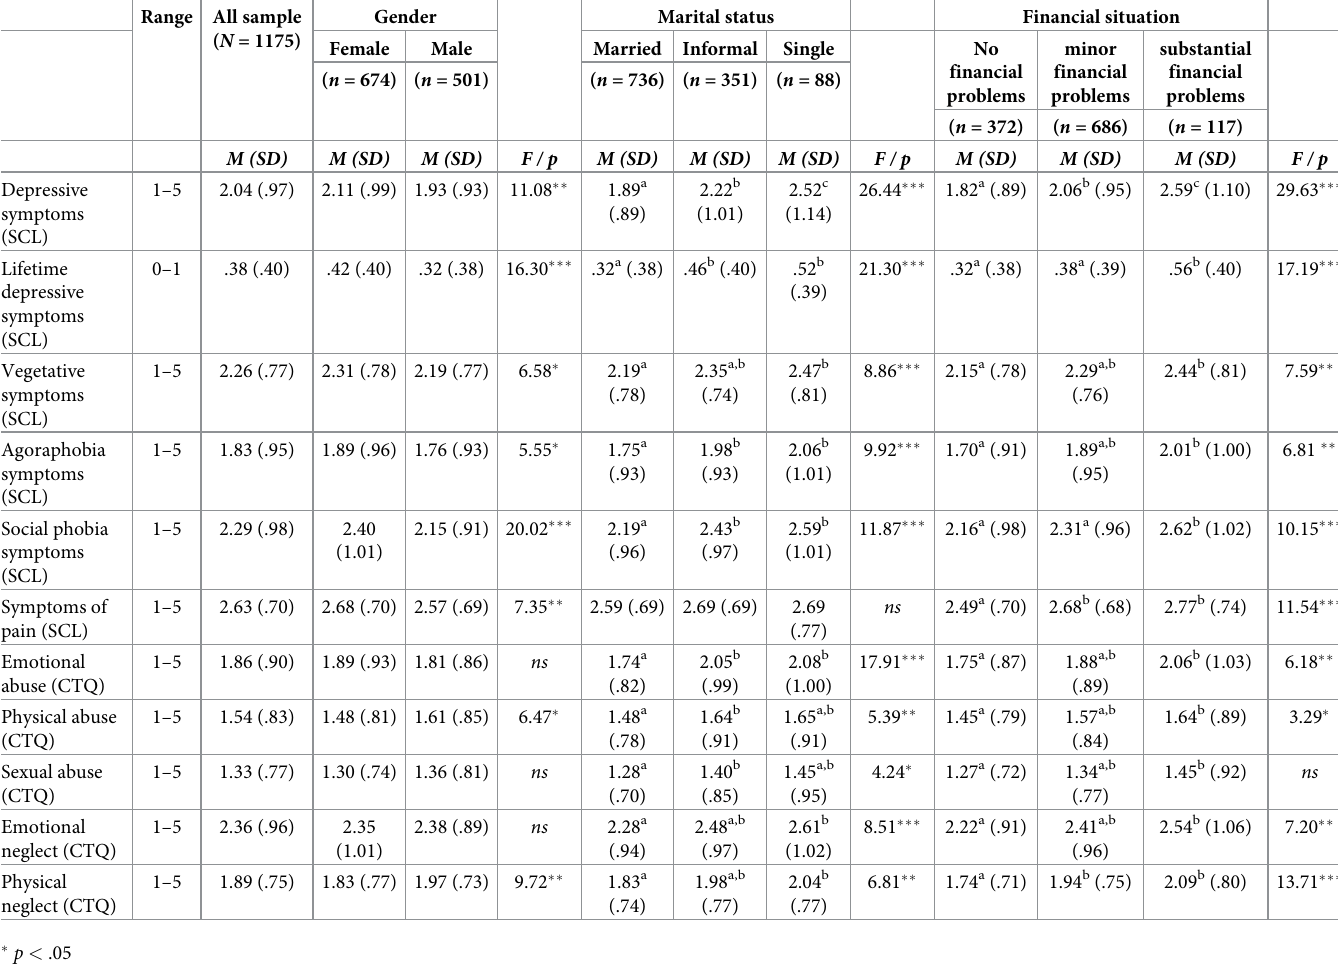
Table 1. Descriptive statistics and mean differences in a study sample (Study 1). Range All sample ( N =